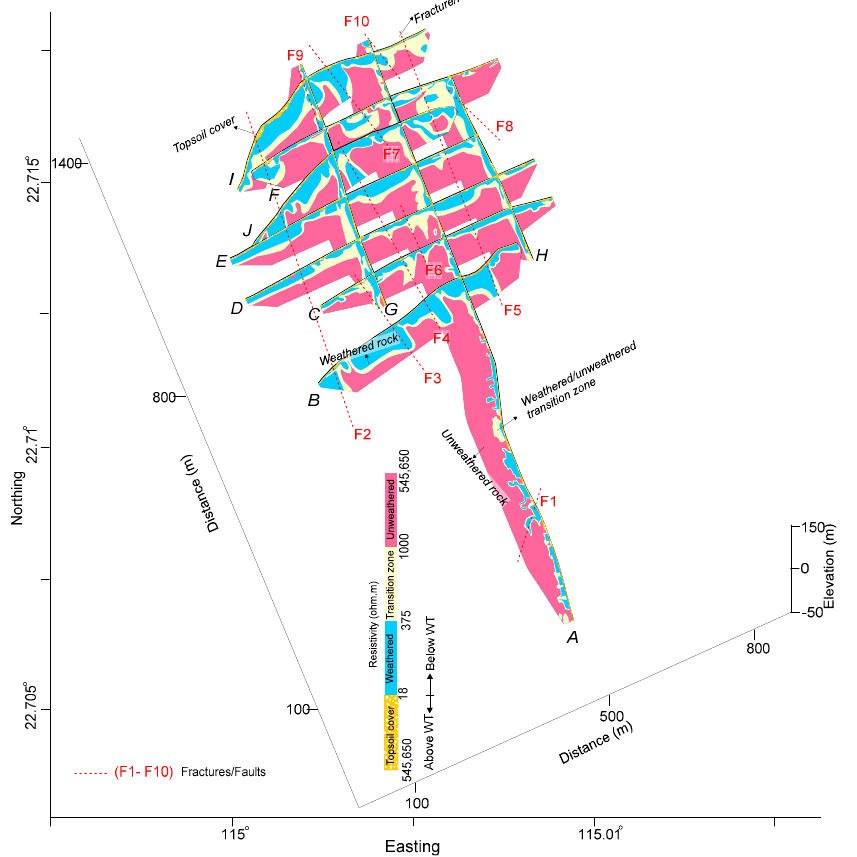
Figure 4. Integration of 2D ERT models along all profiles interpreted for the weathered rock (blue color), weathered/unweathered transition zone or partly weathered rock (yellow color) unweathered rock (pink color), and fractures/faults (dotted reds lines).